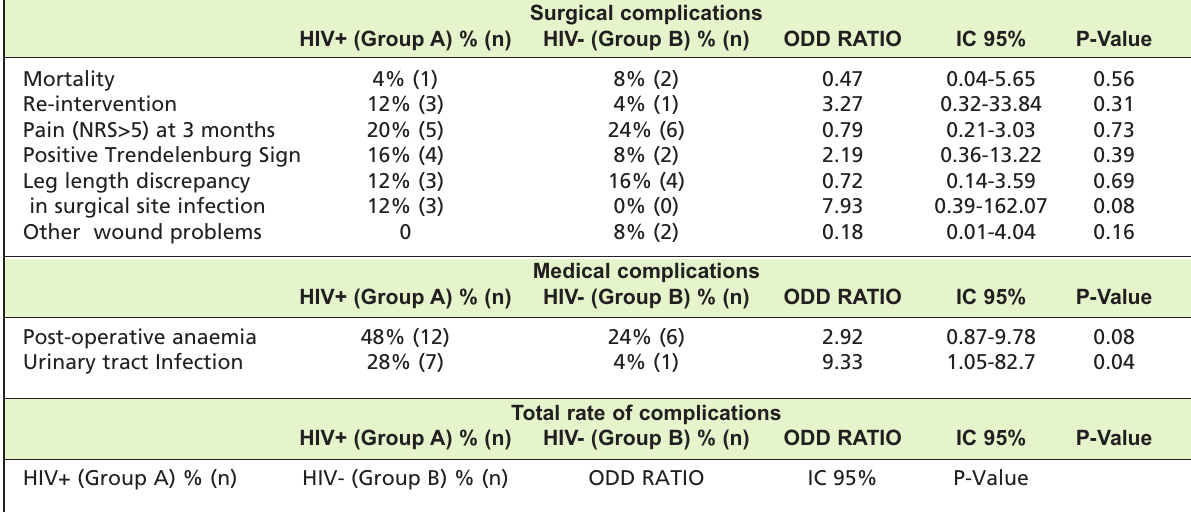
Surgical and medical complication Table III: